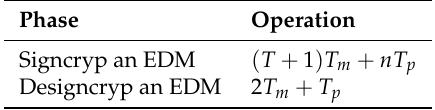
Table 2. Computational cost of signcrypt and designcript ( n is number of receiver).